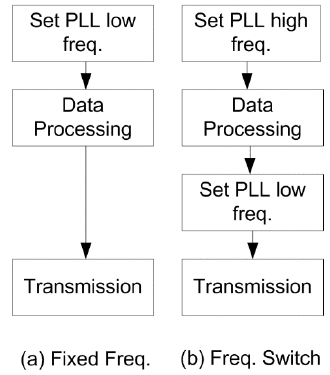
Figure 1 . Difference between ( a ) fixed frequency and ( b ) frequency-switching technique .